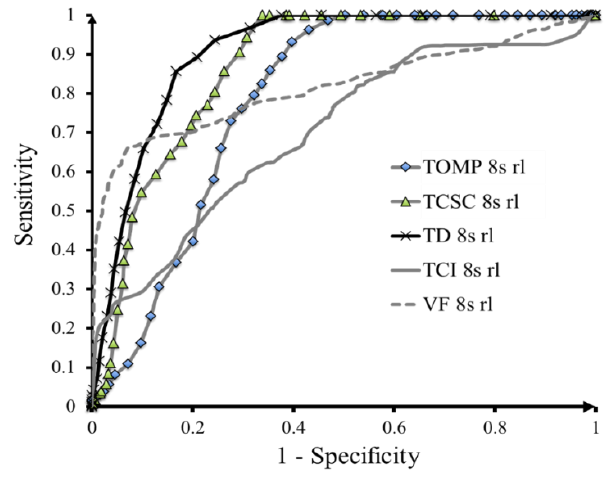
Figure 11. ROC curves for five VF detection algorithms (rl: real-time filter).